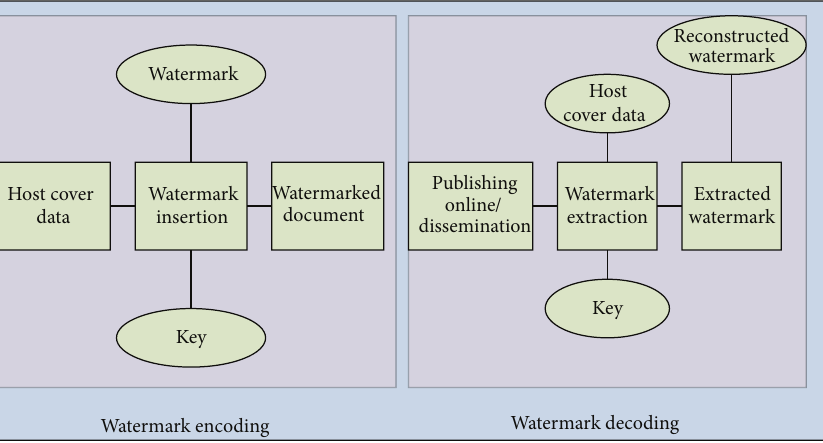
Figure 2: Phases in the watermarking life-cycle.